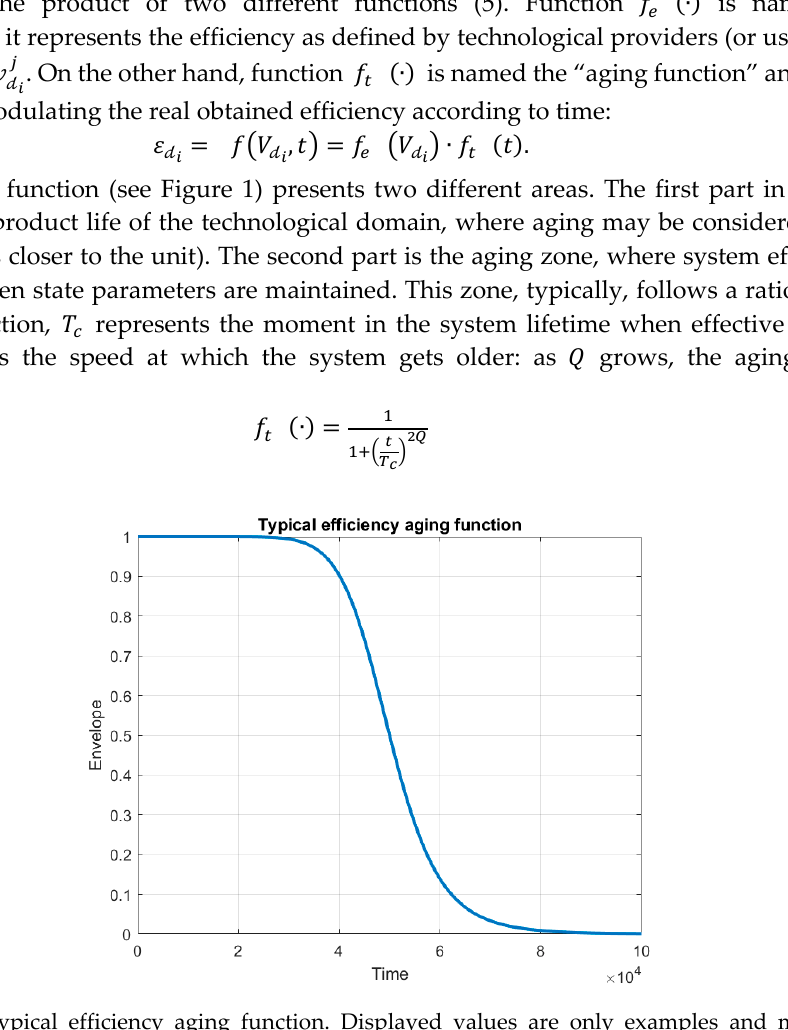
Figure 1. Typical efficiency aging function. Displayed values are only examples and may vary depending on the particular selected